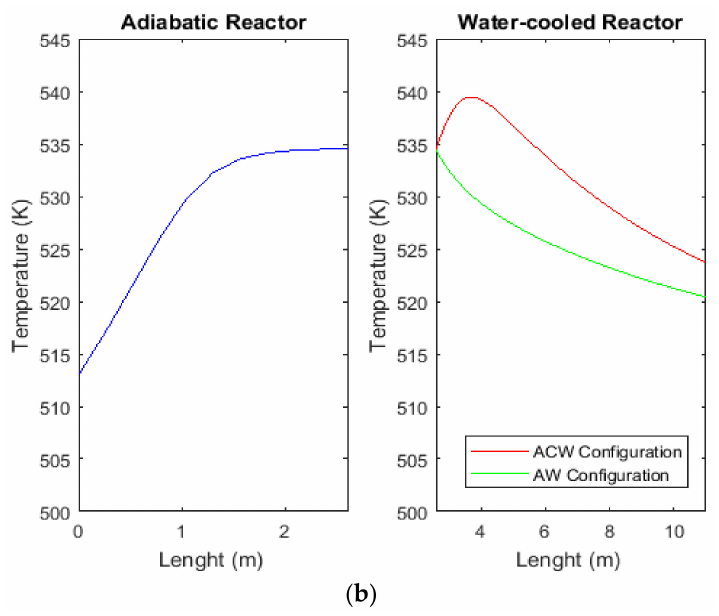
Figure 2. Temperature profile along reactors in ( a ) CR configuration; and ( b ) AW and ACW